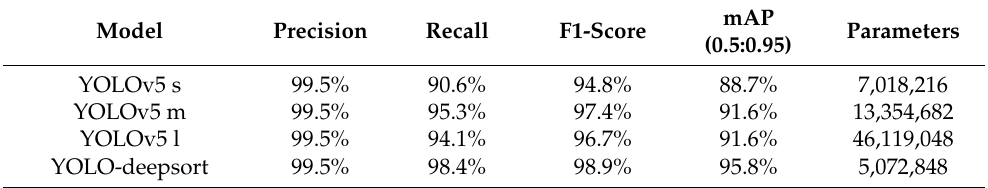
Table 4. The detection results of a series of YOLO networks and YOLO-deepsort.